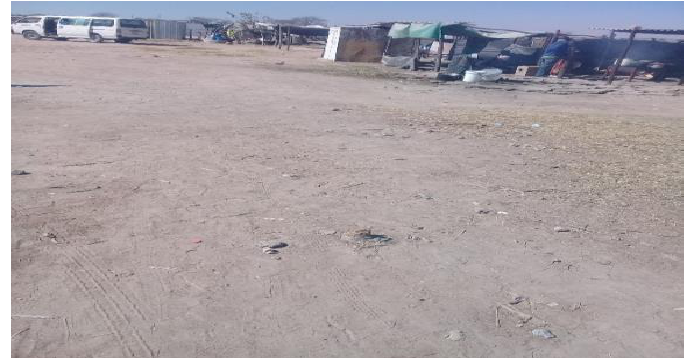
Fig. 1. The make-shift and run-down shopping facilities in Cowdrey Park. (Photo by D. Dube,